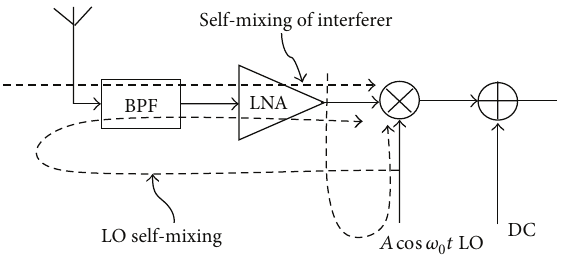
Figure 7: Three main sources of leakages give rise to DC